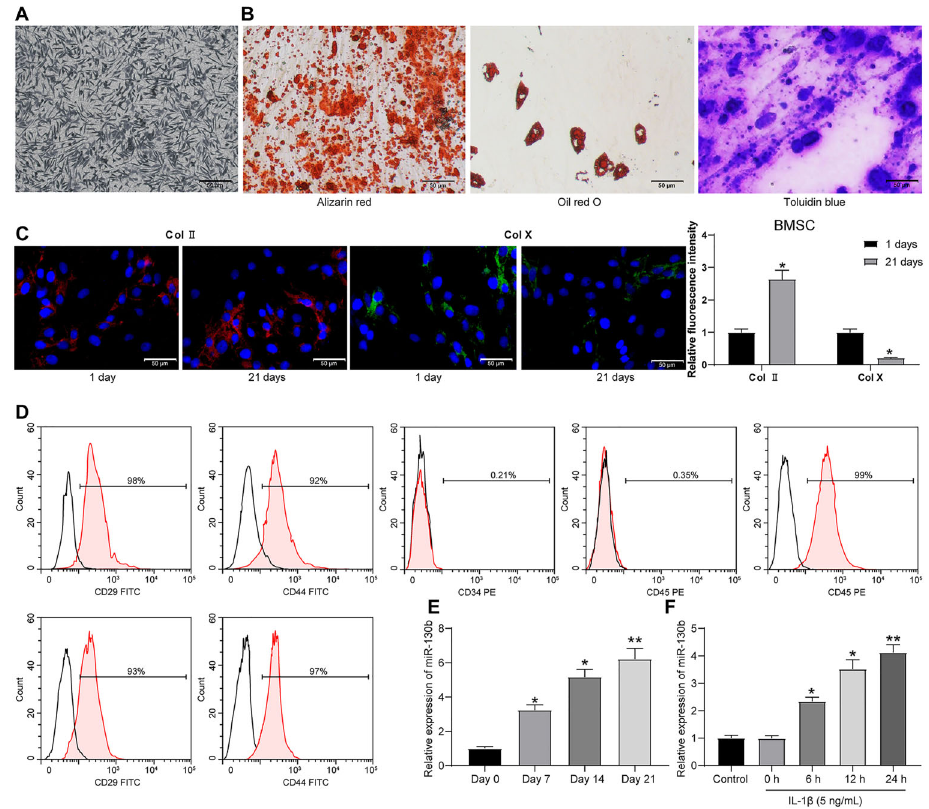
Figure 1. miR-130b is reduced in chondrogenic differentiation and enhanced in osteoarthritis chondrocytes. A , Morphology of bone marrow mesenchymal stem cells (BMSCs) observed by electron microscope. B , Alizarin red staining, oil red O staining, and toluidine blue staining were used to measure the osteogenic, lipogenic, and chondrogenic abilities of BMSCs (scale bar, 50 m m). C , Col II and Col X expression in BMSCs determined by immuno fl uorescence assay (scale bar, 50 μ m). D , Flow cytometry identi fi ed BMSCs. E , RT-qPCR measured miR-130b expression in chondrogenic differentiation of BMSCs. F , RT-qPCR measured miR-130b expression in interleukin-1 b -treated chondrocytes. The data in panels E and F were analyzed using one-way ANOVA, and the data in panel C were analyzed using two-way ANOVA. *P o 0.05, **P o 0.01 compared to control. Experiments were repeated 3 times